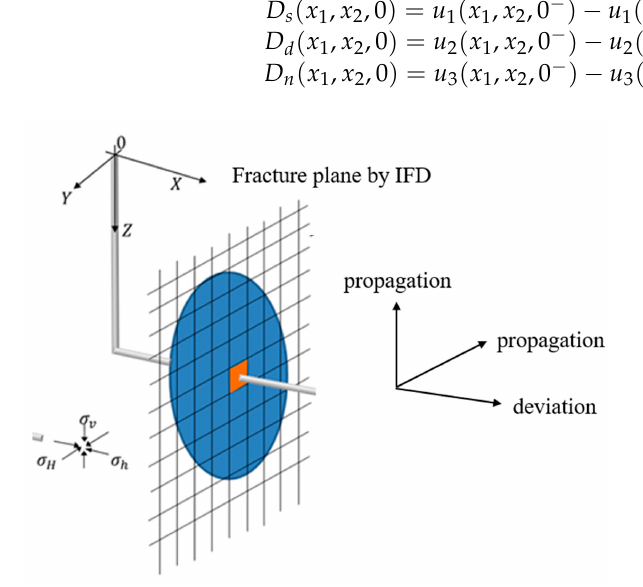
Figure 5. D view of the fracture plane with IFD